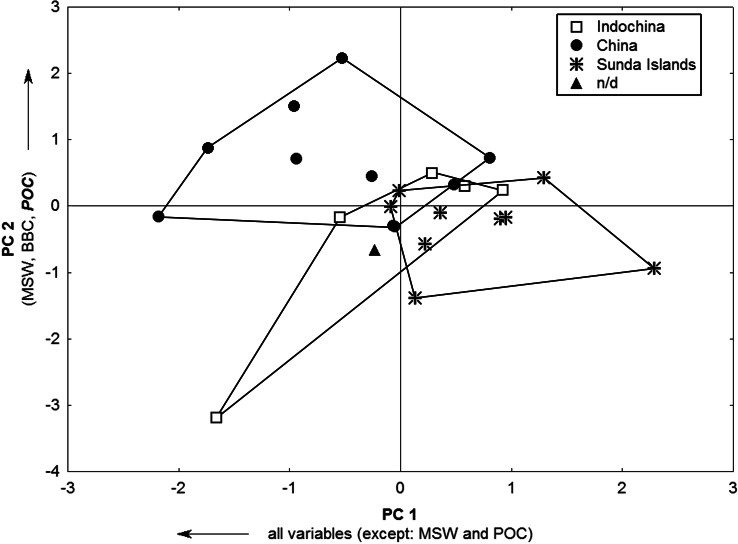
Leopard cat skull PCA morphospace across Asian regions.Bivariate plot of 25 P. bengalensis according to individual principal component scores, considering three major geographical regions. Arrows indicate the direction of the contribution of variable loadings to the respective principal components (PCs). Subregions are identified for each individual.